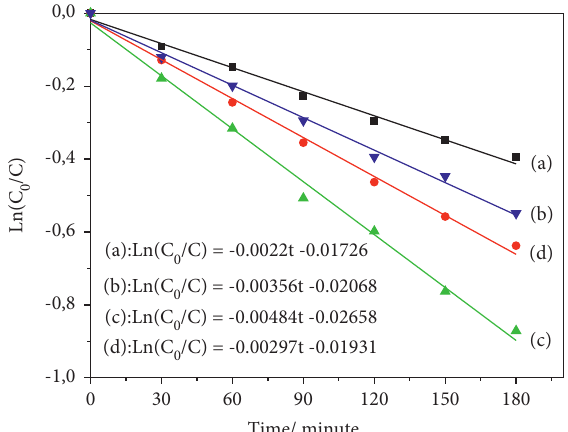
Figure 9: The first-order kinetics of photodegradation of 2,4-D on the catalyst (a): C 5Ti-SBA-15/C 3 N 4